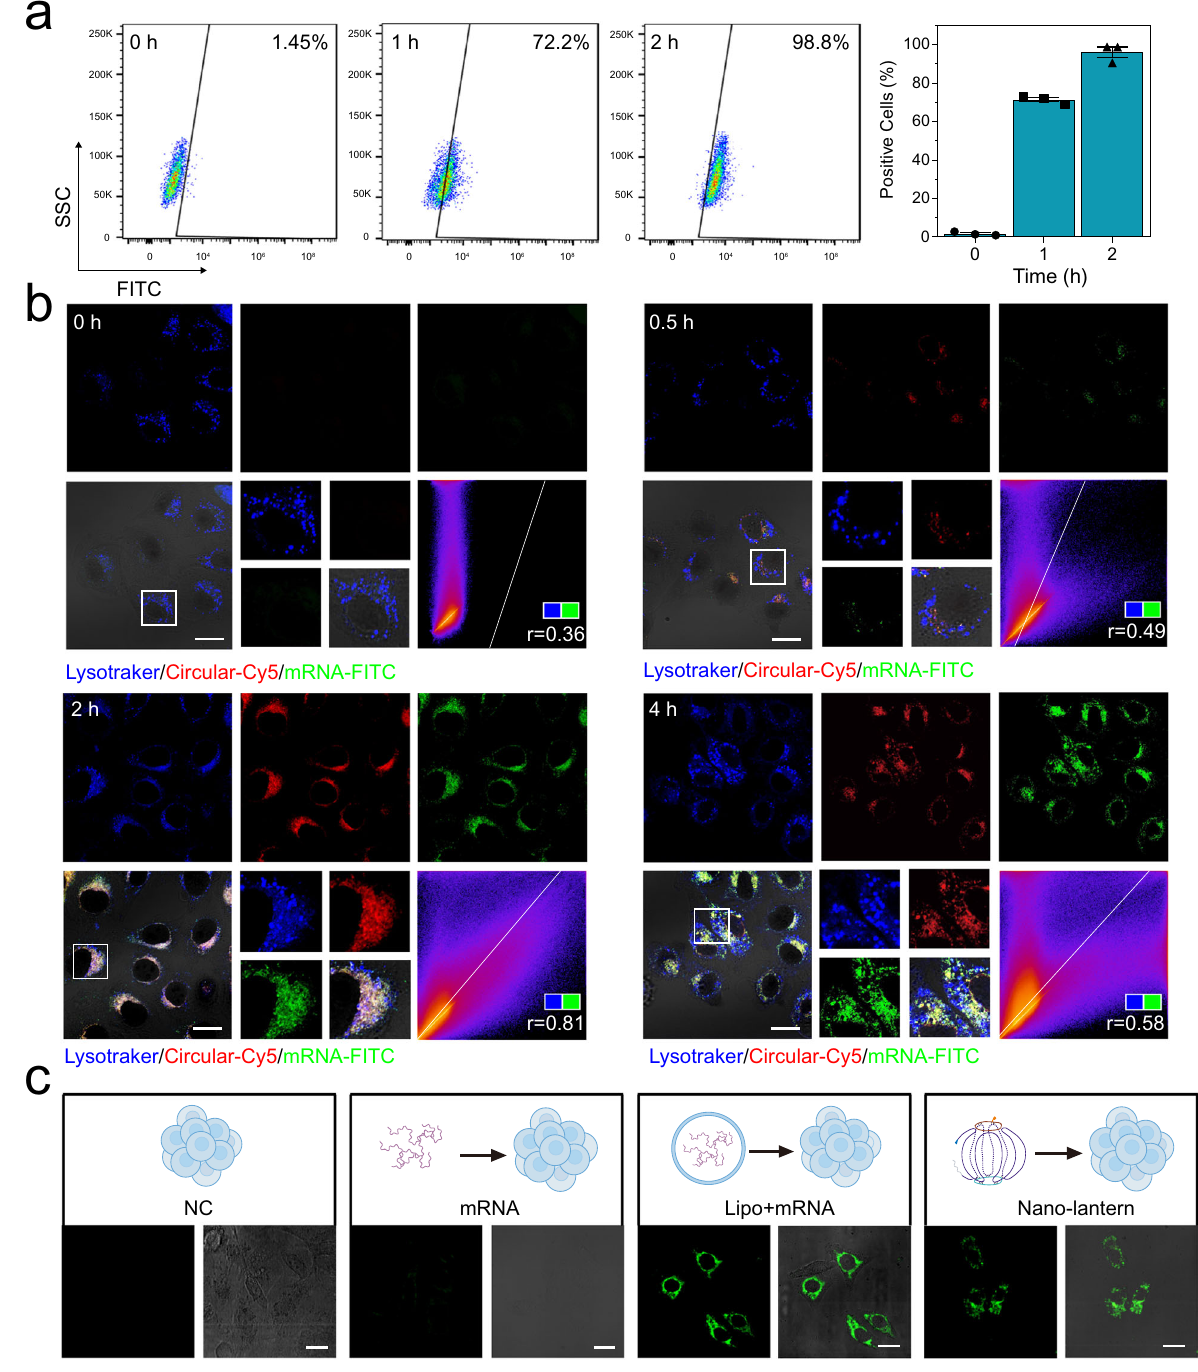
Fig. 4 |Cellularuptakeof Smad4 mRNA nano-lantern.a Flowcytometry analysis of the cellular dynamic uptake of mRNA nano-lantern in SW480 cells at different time points, n =3 independent biological samples, data are presented as the mean±SEM. The gating strategy was provided in the Supplementary Fig. 16b. b Representative confocal images of SW480 cells incubated with mRNA nano- lantern at different time points, the images at each time point are from 3 inde- pendentexperiments.FluorophoreCy5wasexploitedtolabeltheRGD-CSRNAand macropinocytosis), methyl-beta-cyclodextrin (MBCD, inhibitor of cholesterol-dependent endocytosis), chlorpromazine (CHL, inhibitor of clathrin-mediated endocytosis), and nystatin (NYS, inhibitor of lipid raft-caveolae endocytosis). As shown in Supplementary Fig. 8, after treatment withCHL and NYS,the fl uorescence intensity in SW480cells